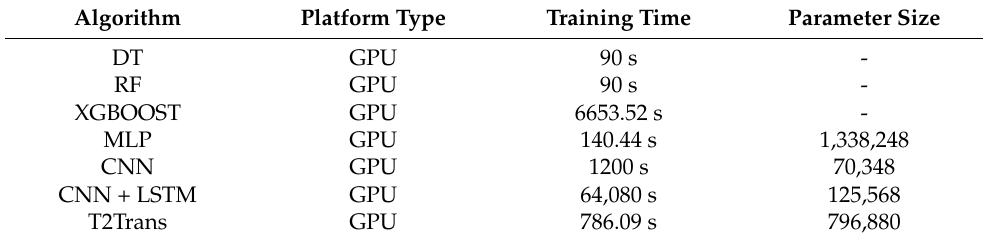
Table 8. The training and predicting time of different